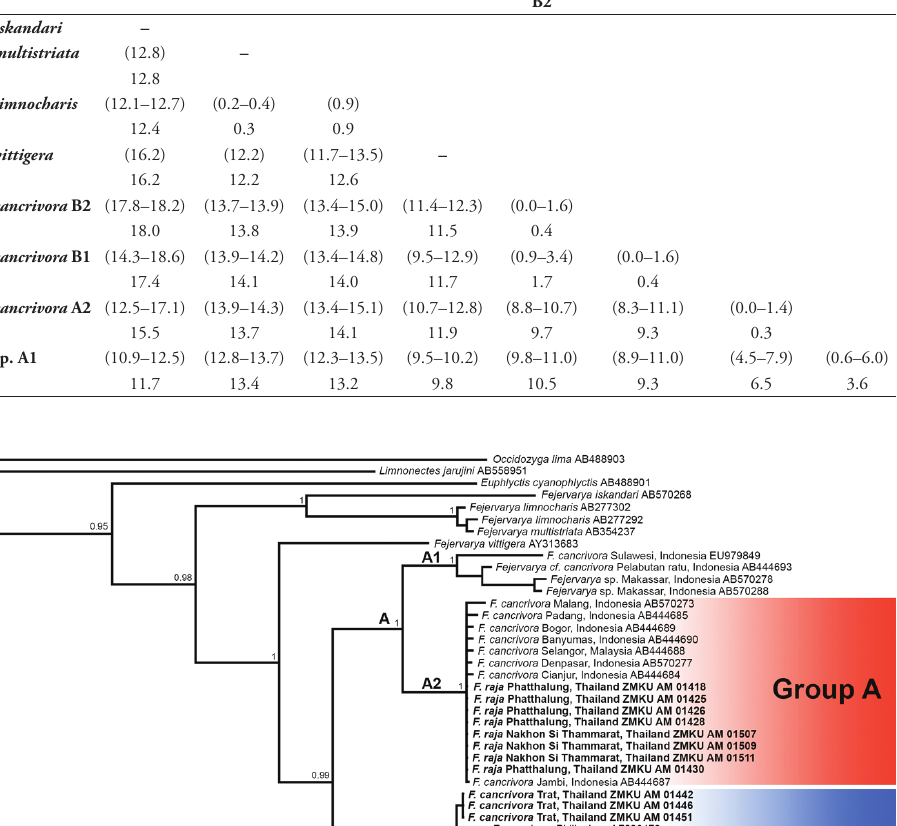
Table 2. Uncorrected pairwise sequence divergences ( p -distances) in the mitochondrial 16S rRNA gene of Fejervarya cancrivora and related species. Mitochondrial subclades A1, A2, B1, and B2 are defined in the text. iskandari multistriata